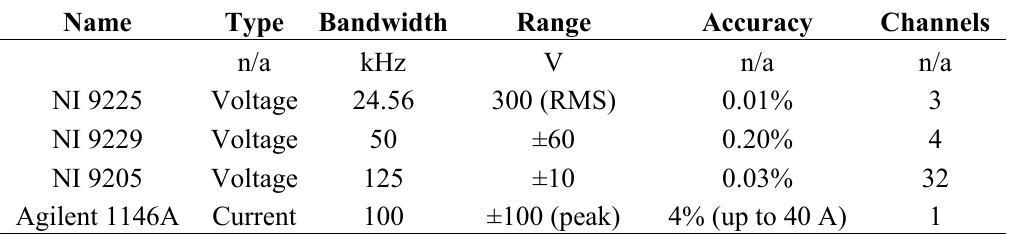
Table 2. Description of hardware used for